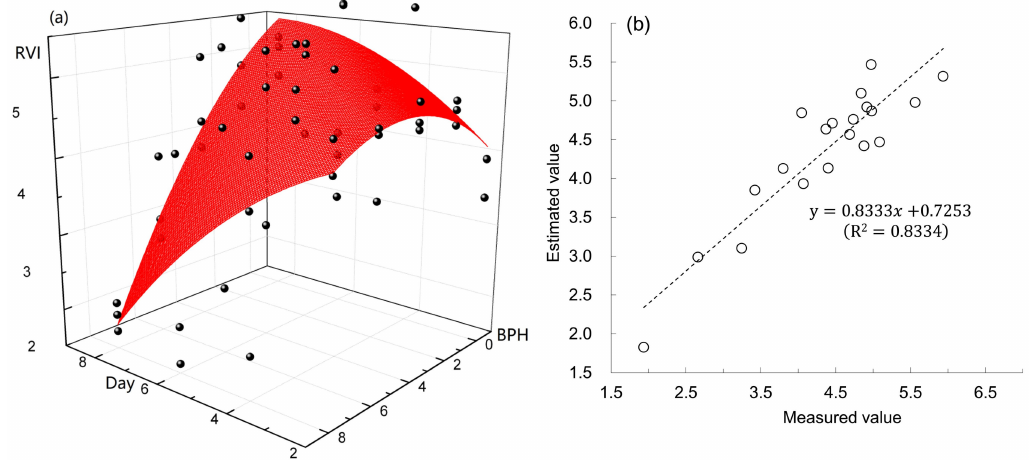
Figure 9. The quadratic surface model for simulating the relationships between RVI 746/670 , the number of BPH and exposure day ( a ), and the linear relationship between estimated RVI 746/670 values based on the model and measured values from rice plants ( b